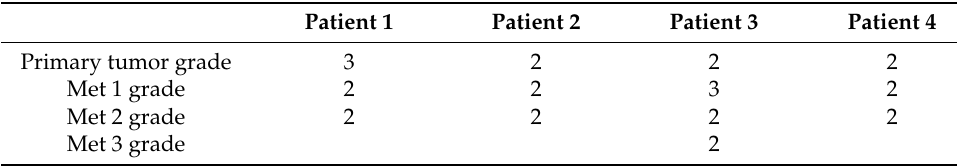
Table 2. Grade of the primary tumors and metastases.